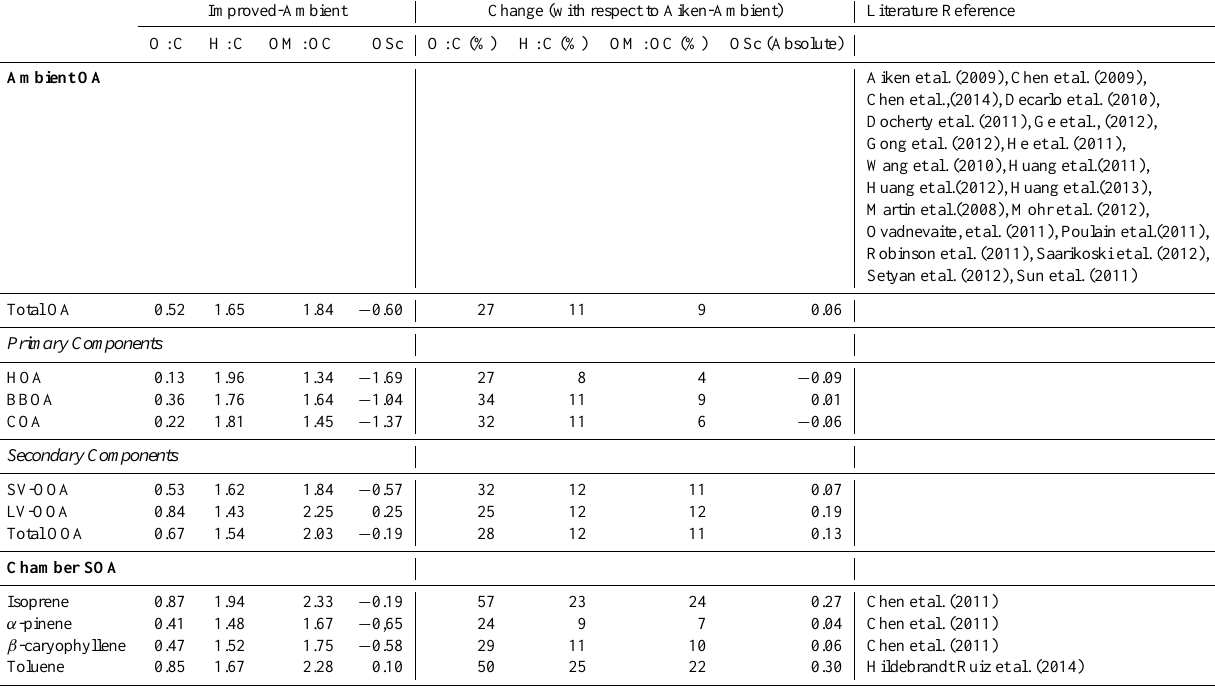
Table 3. Summary of elemental composition information obtained for chamber and ambient OA. Improved-Ambient Change (with respect to Aiken-Ambient)